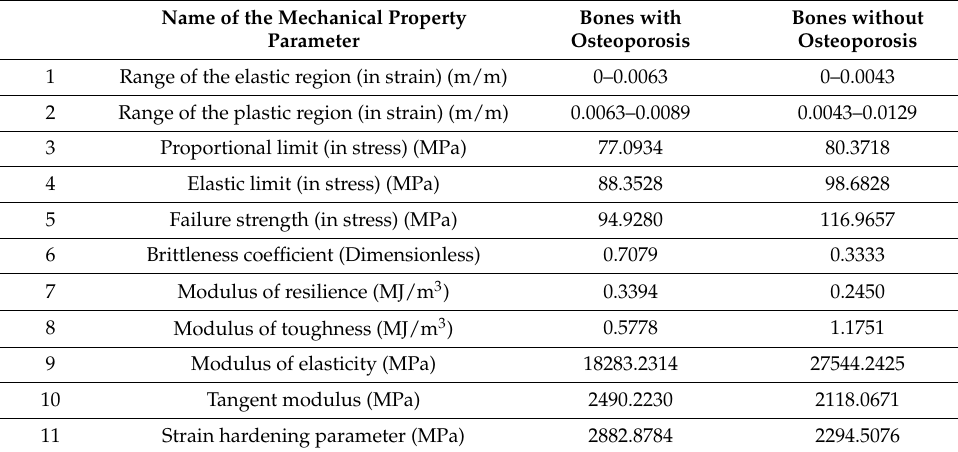
Table 2. Mechanical properties of bones with and without osteoporosis.